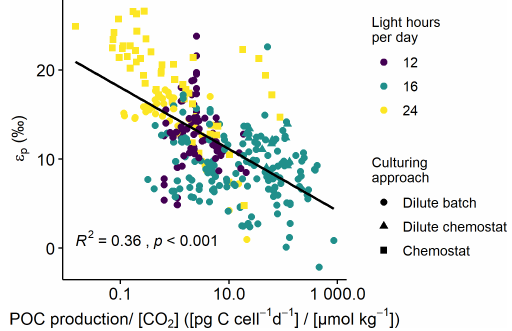
Figure 1. ε p against POC production / [CO 2 ] (C-demand/C-supply; log-transformed) across all phytoplankton groups. Colors indicate the light-dark cycle; marker shapes indicate the culturing approach. Black line illustrates the log-linear relationship ( R 2 and p -value indicated in the